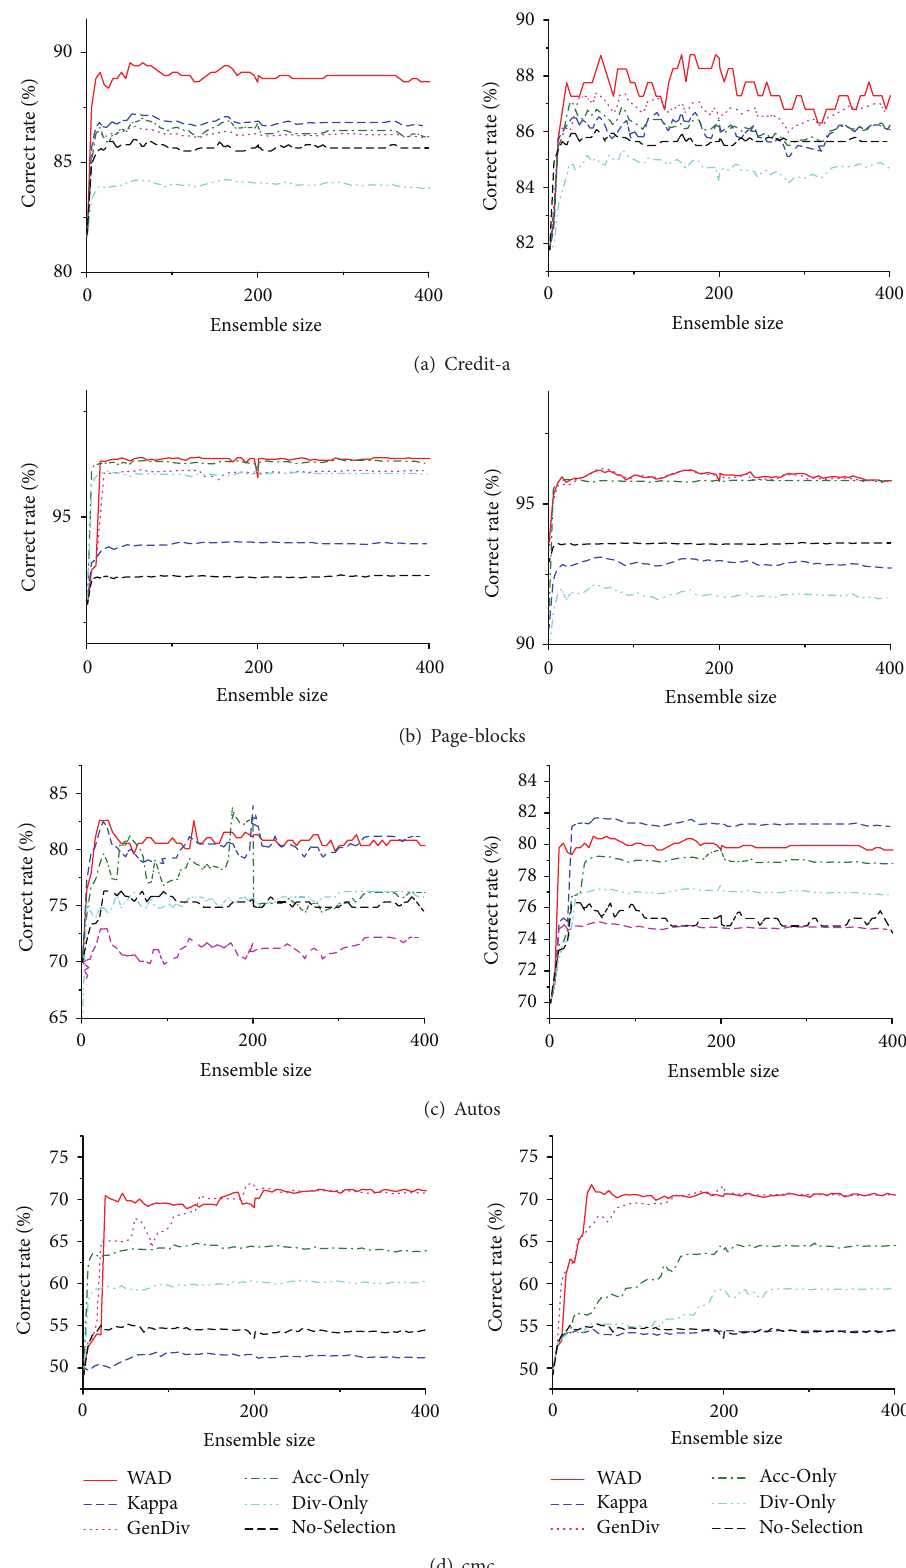
Figure 1: The curves of the classification correct rate on four representative datasets: credit-a, page-blocks, autos, and cmc. The left graphs report the ensemble selection cases using FHC search, while the right ones using GA